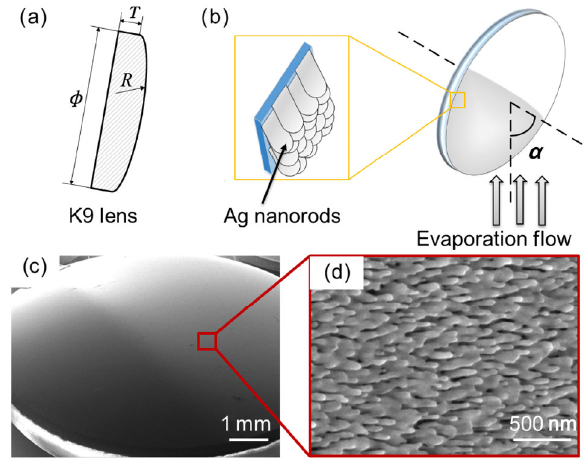
Fig. 2 (a) Illustration of a K9 plano-convex lens, (b) schematic of the OAD technique, (c) SEM image of the K9 plano-convex covered with Ti and Ag films, (d) SEM image of Ag